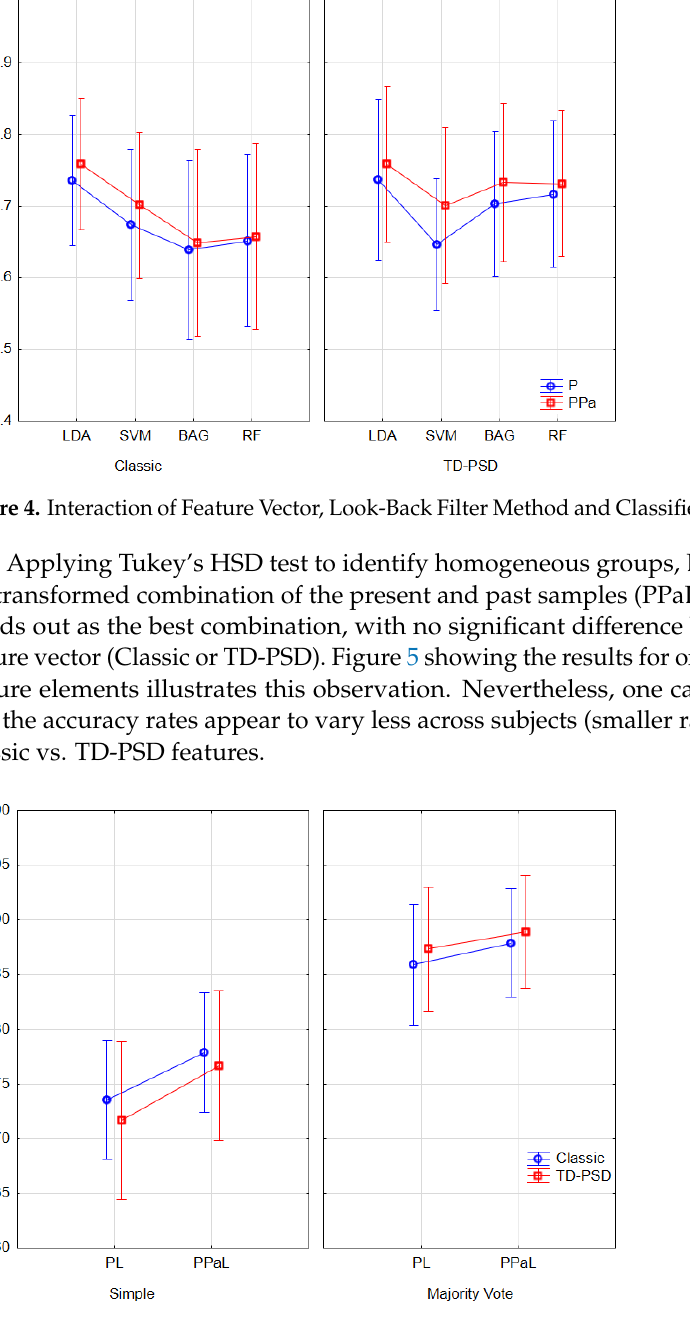
Figure 5. Specific ANOVA analysis of